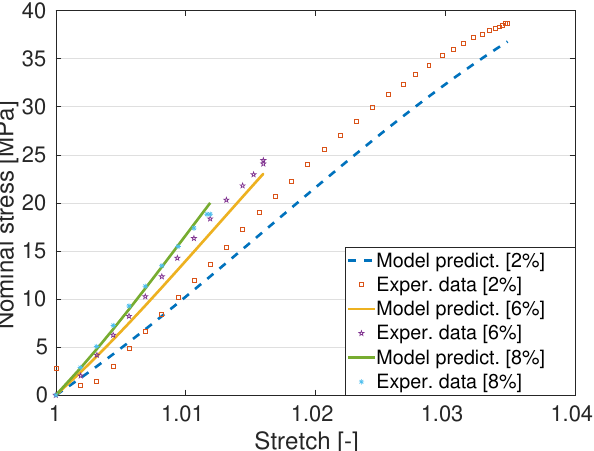
Figure 9. Model prediction using the three-parameter Carrol non-linear model. The predictions are relatively good with the experimental data of three different PET/GNP